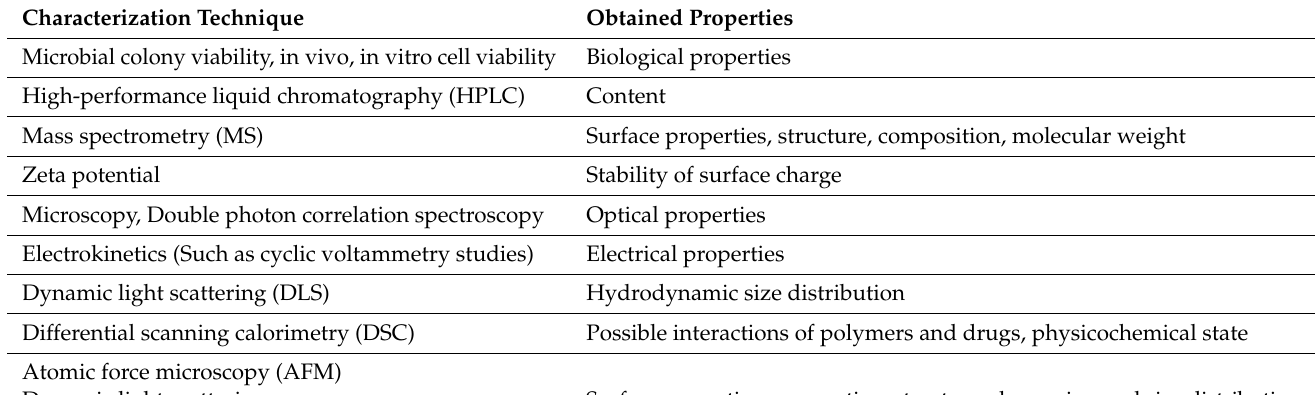
Table 2. Characterization techniques used to identify the properties of